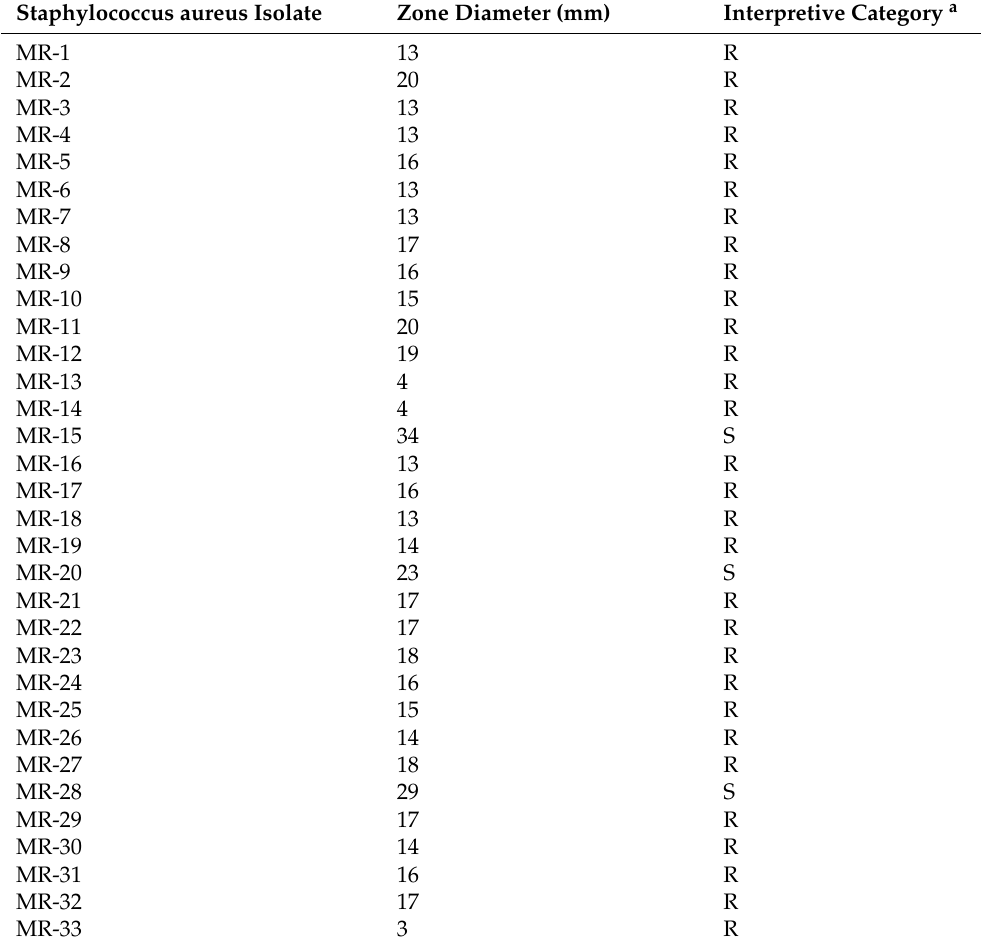
Table 1. The antimicrobial disk susceptibility tests with cefoxitin 30 µ g disks. Staphylococcus aureus Isolate Zone Diameter (mm)